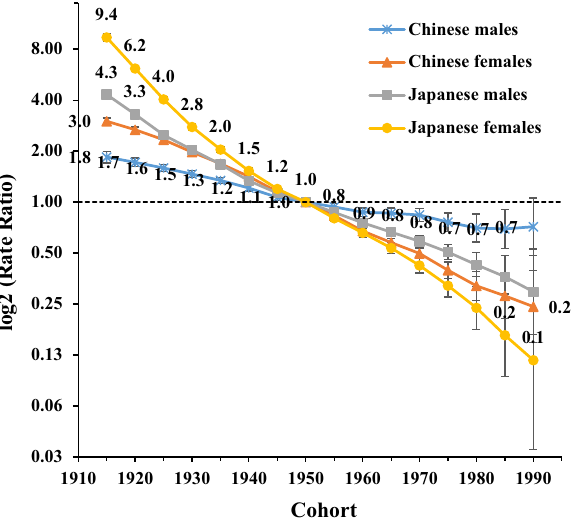
Figure 6. Cohort relative risks (RRs) of high SBP-attributable stroke mortality rate by sex in China and Japan. The relative risk of each cohort compared with the reference one (cohort 1950) adjusted for age and nonlinear period effects. Error bars represent the 95%CIs for the cohort relative risks. Japanese men 1990: Population: 38 067 229; Stroke: 38 690, 1995: Population: 40 061 997; Stroke: 43 172, 2000: Population: 42 325 105; Stroke: